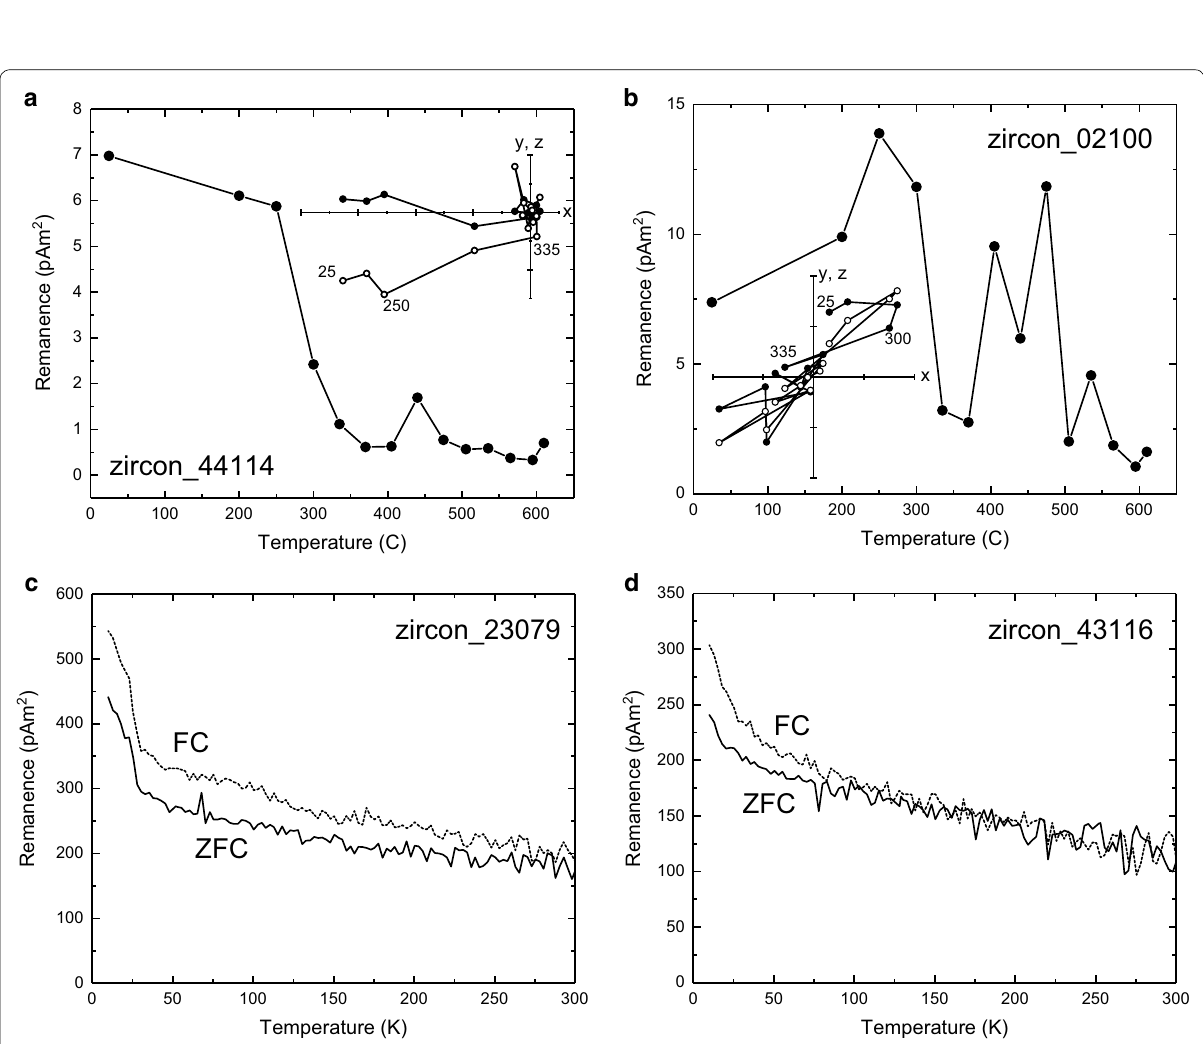
Fig. 4 Results of experiments on selected zircon. a , b Stepwise ThD of NRM. In the orthogonal plot, open and closed circles indicate X – Y and X – Z planes, respectively. c , d Low-temperature remanence measurements. Solid lines for ZFC measurements and dotted lines for FC